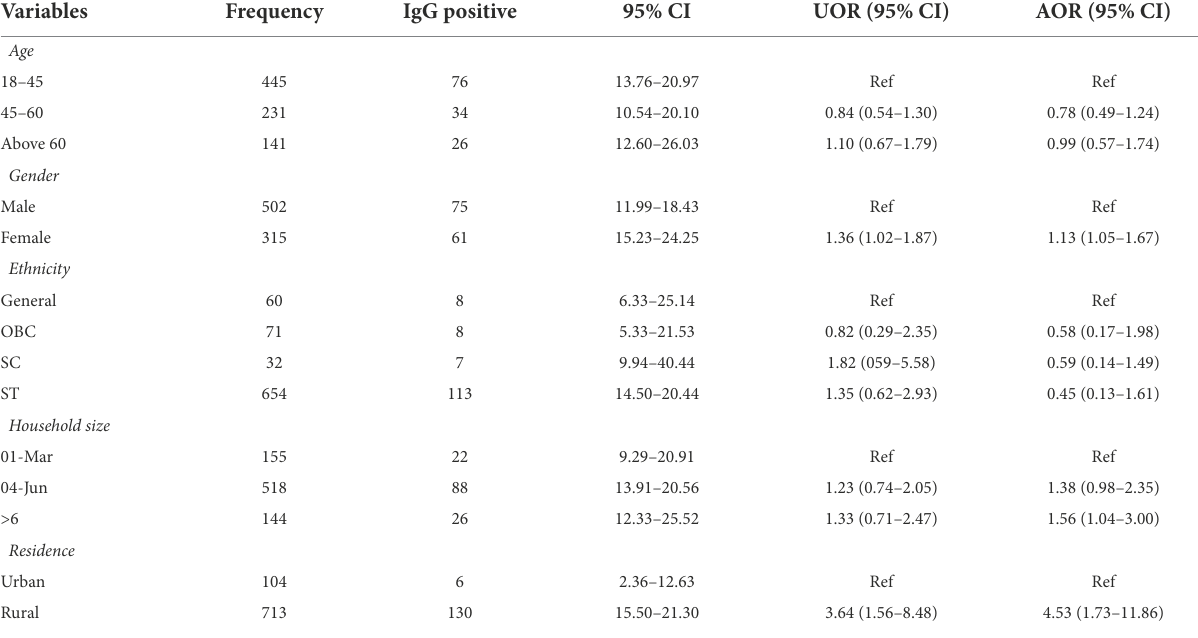
TABLE 3 Sociodemographic risk factors associated with human